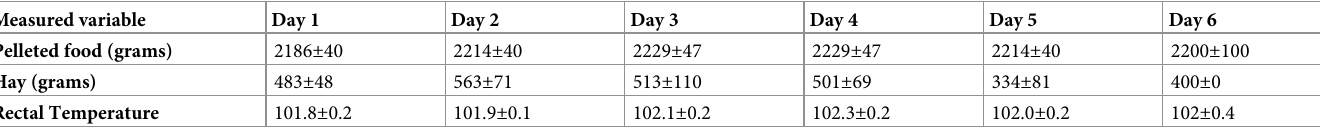
Table 2. Daily food and hay consumption and rectal temperature data from sheep inoculated with fluorescent protein-expressing SH1000 S . aureus . Rectal tempera- tures in Fahrenheit during experimental period after inoculation (n = 7). Criterion for statistical significant was P < 0.05 (One-way ANOVA). Data are represented by means ± SEM. No significant change was